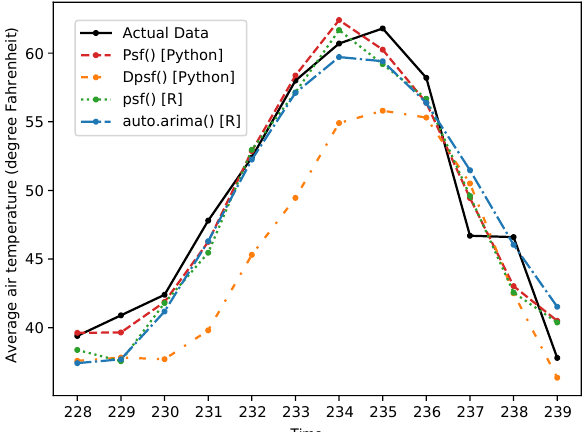
Figure 4. Plot showing the test data and values forecasted using various methods for the “nottem” dataset.